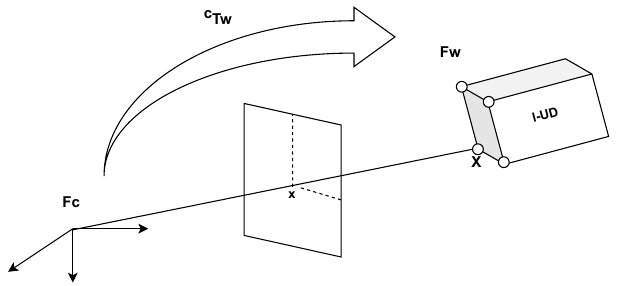
Figure 3. Rigid transformation c T w between the world image, F w , and the camera image, F c , and the projection in